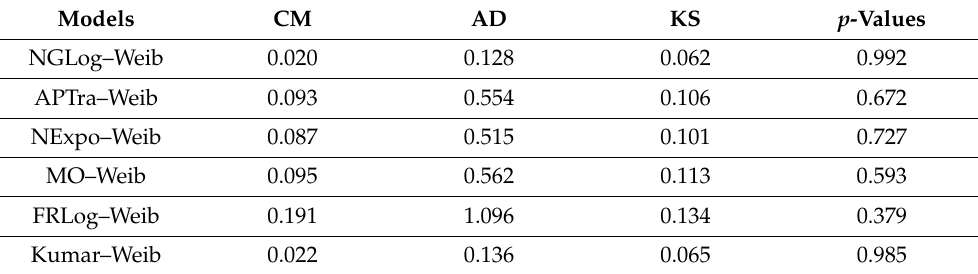
Table 10. The GFMs and p -values of the competing models for head and neck cancer data (dataset 2).